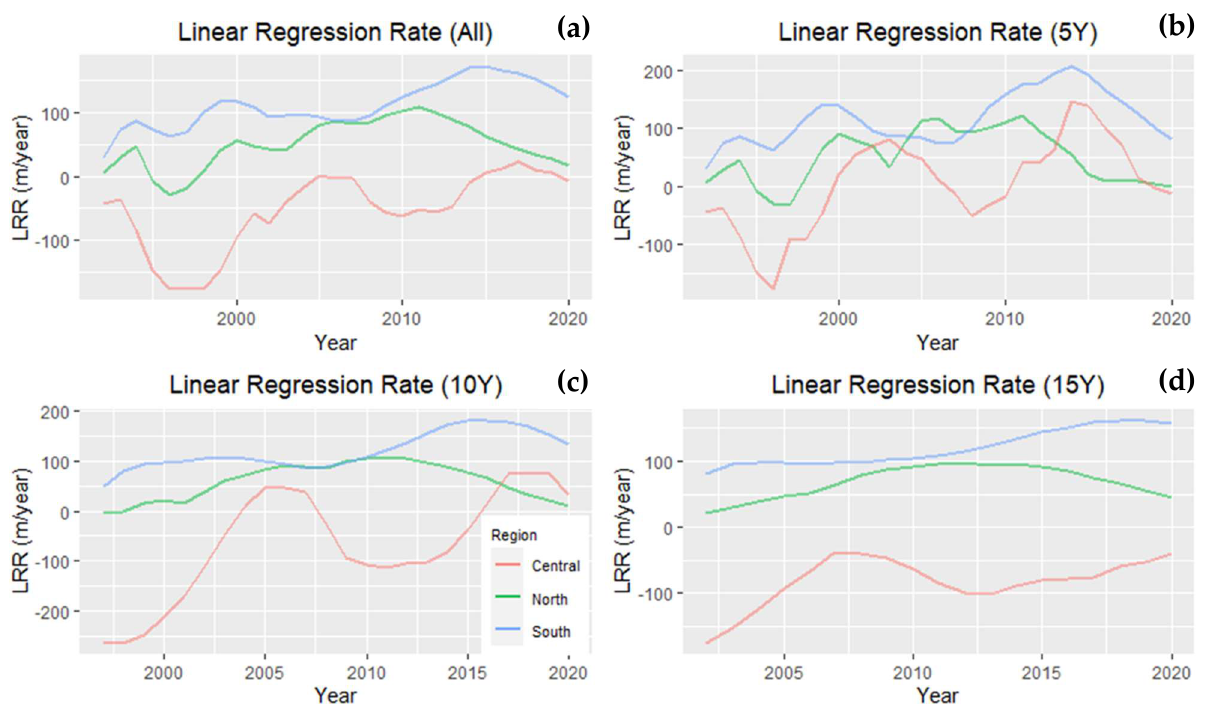
Figure 4. Linear regression rate of shoreline movement over time and space: ( a ) average of all time depths, (b) 5 years’ time depth, ( c ) 10 years’ time depth, and ( d ) 15 years’ time depth. In the figure, positive values indicate erosion and negative values indicate accretion.